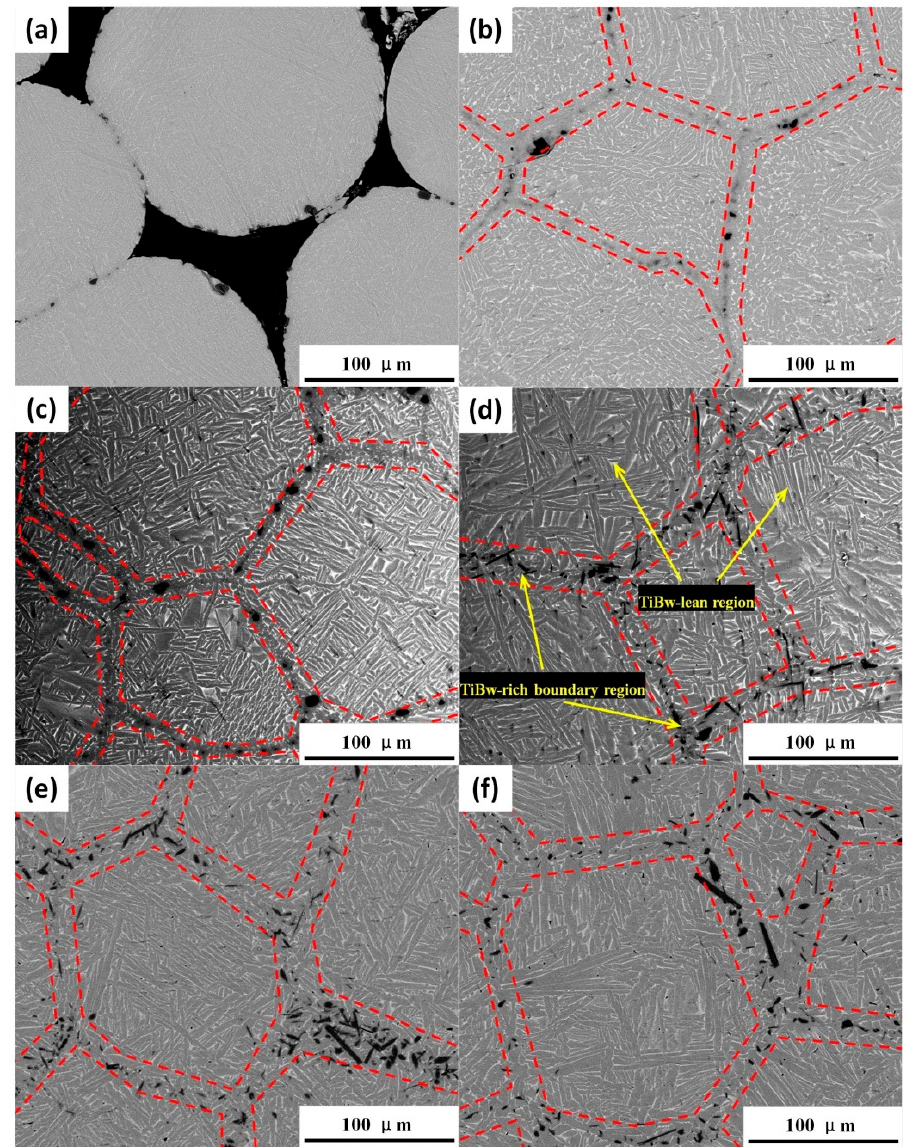
Figure 3. The typical SEM micrographs of the samples sintered at different temperatures: ( a ) 800 °C; ( b ) 900 °C; ( c ) 1000 °C; ( d ) 1100 °C; ( e ) 1200 °C; ( f ) 1300 °C.